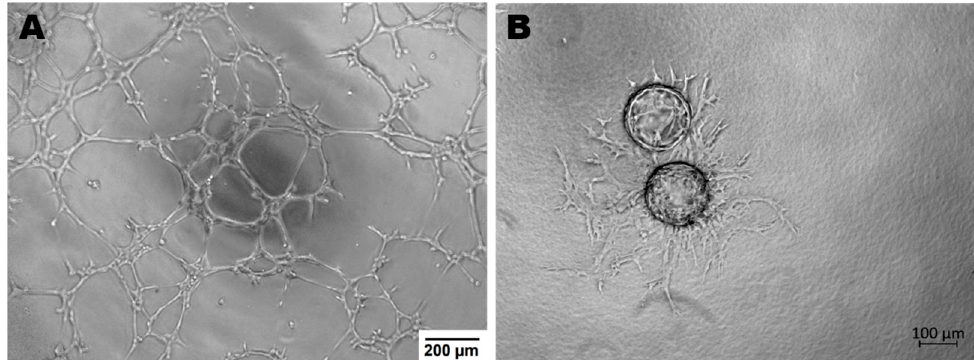
Figure 2. Endothelial cells ability to angiogenesis in vitro. ( A )—Tube Formation Assay, magnification 4×; ( B )—Sprouting Assay based on Cytodex beads, magnification 5×; both assays were performed with murine brain derived endothelial cells (MBr MEC FVB).